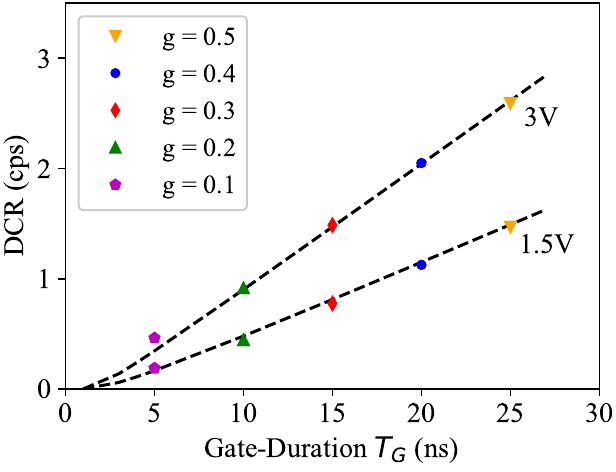
Figure 6. Dark-count rate as a function of the gate-ON time. The dashed lines show the model fit using Equation